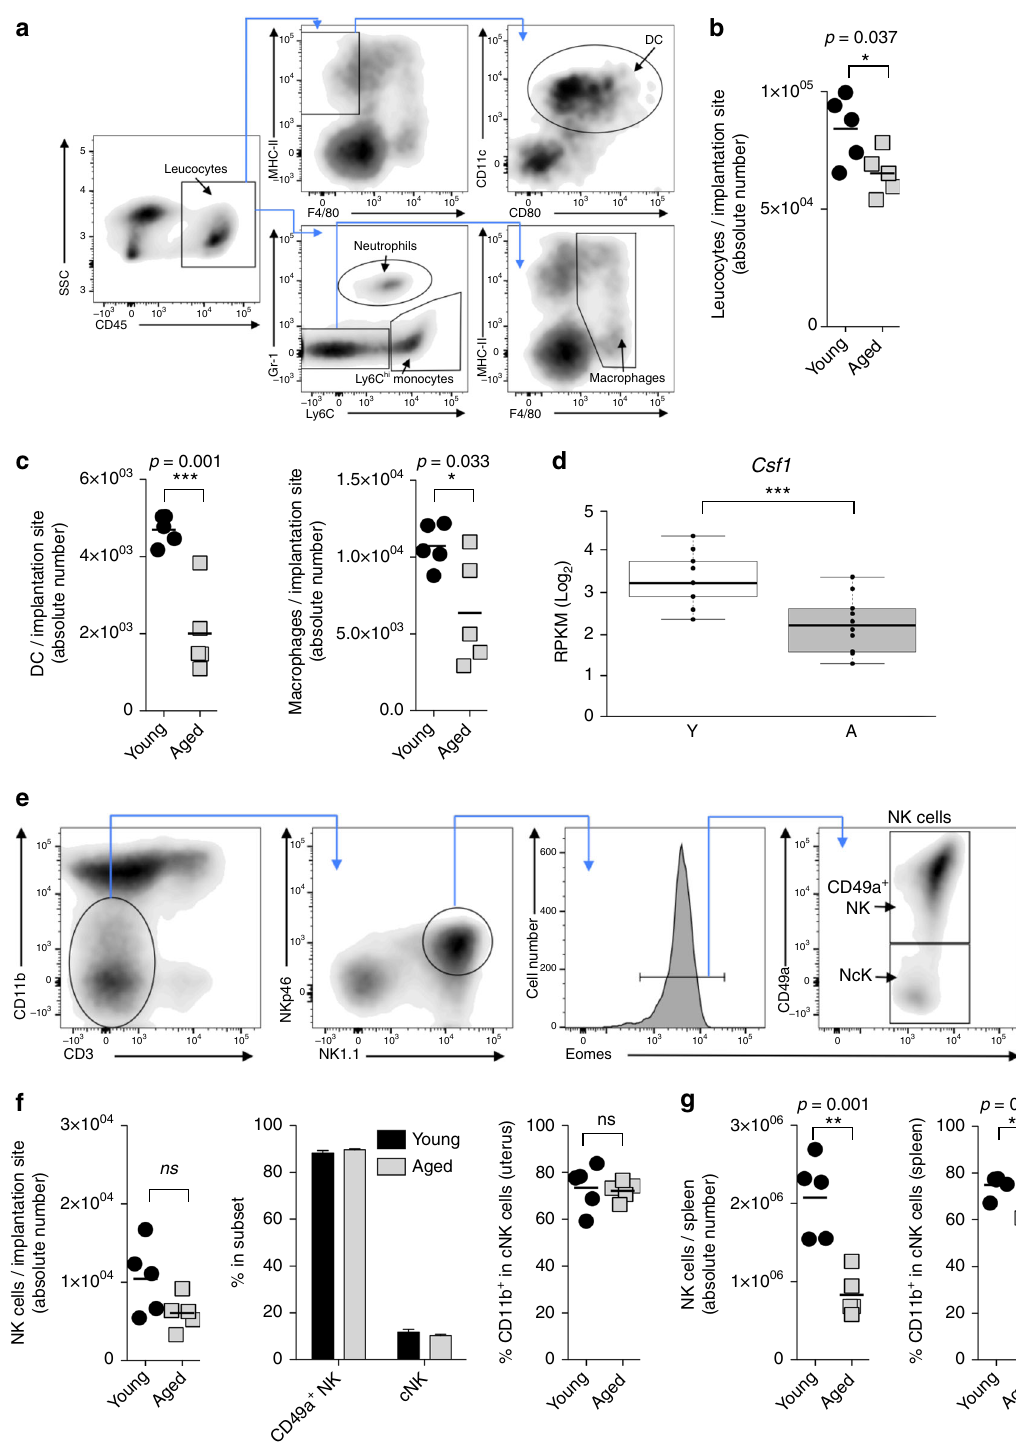
Fig. 4 Altered leucocyte composition at the maternal-fetal interface at mid-gestation. a Flow cytometry analysis of decidual leucocytes: gating strategy showing delineation of uterine cells into macrophages and dendritic cells (DCs, pre-gated on live singlets). b Absolute number of leucocytes recovered per implantation site. c Enumeration of macrophages and DCs at the maternal-fetal interface. d Expression levels of Csf1 , a key cytokine of DC cell maturation, as determined by RNA-seq, displayed as normalised read counts of 9 (young = Y) and 10 (aged = A) independent replicates. Data are displayed as mean ± S.E.M. *** p < 0.001 (two-tailed t test). e Gating strategy used to identify uNK cells and delineation into tissue-resident CD49a + and conventional CD49a − cells (pre-gated on live singlets). f Enumeration of NK cells per implantation site and relative abundance of tissue-resident and conventional uNK cells, as well as frequency of more mature CD11b + uNK cells. g Enumeration and maturation phenotype of peripheral splenic NK cells in pregnant females. Each data point in b , c , f and g represents an entire litter of one pregnant mouse, values in f are means ±